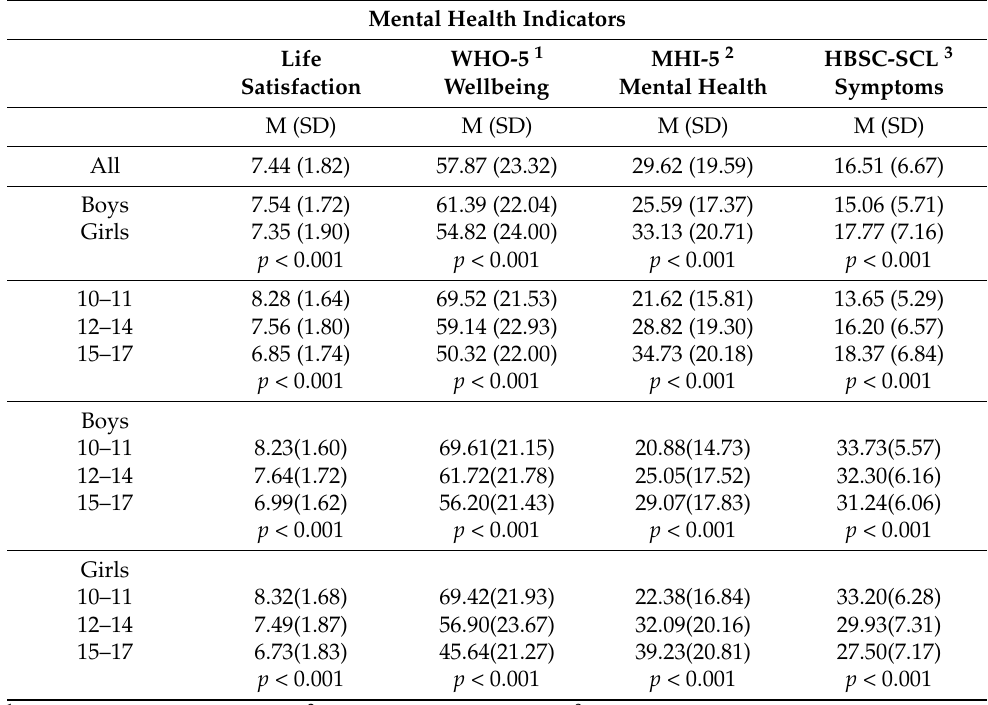
Table 1. Indicators of wellbeing and mental health by gender and age